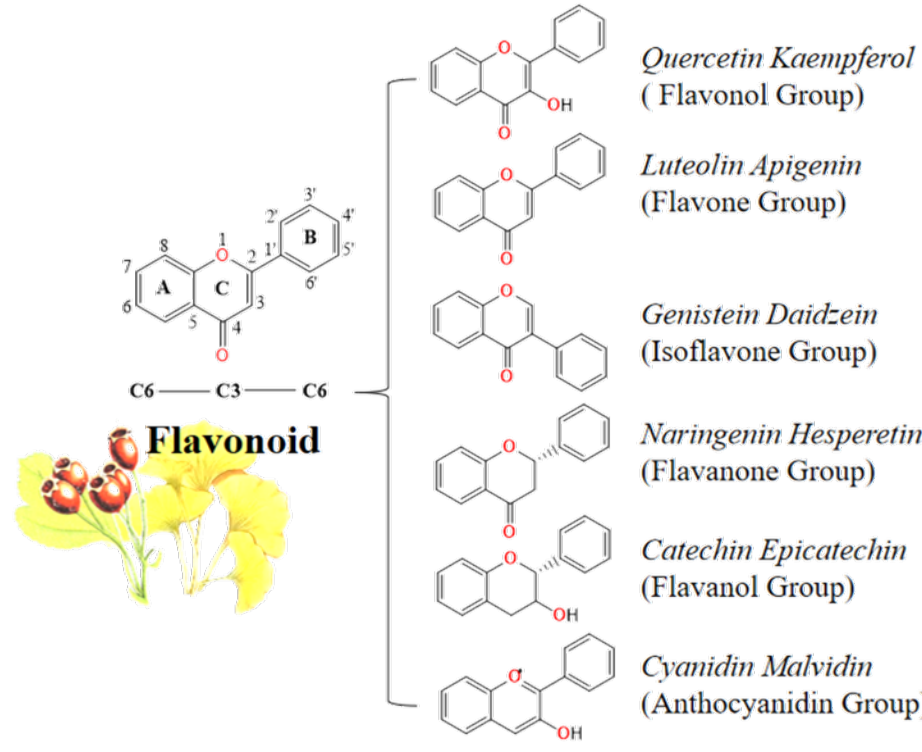
Figure 1. Classification of flavonoids.